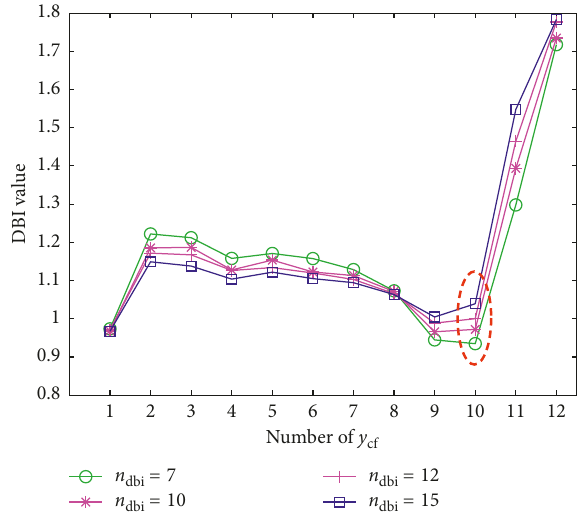
Figure 11: Experiment II: the DBI values for R